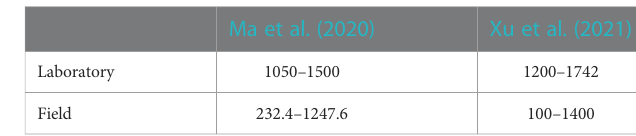
TABLE 1 Ranges of Laser Intensity in the Laboratory and Field Observations (unit: W m -2